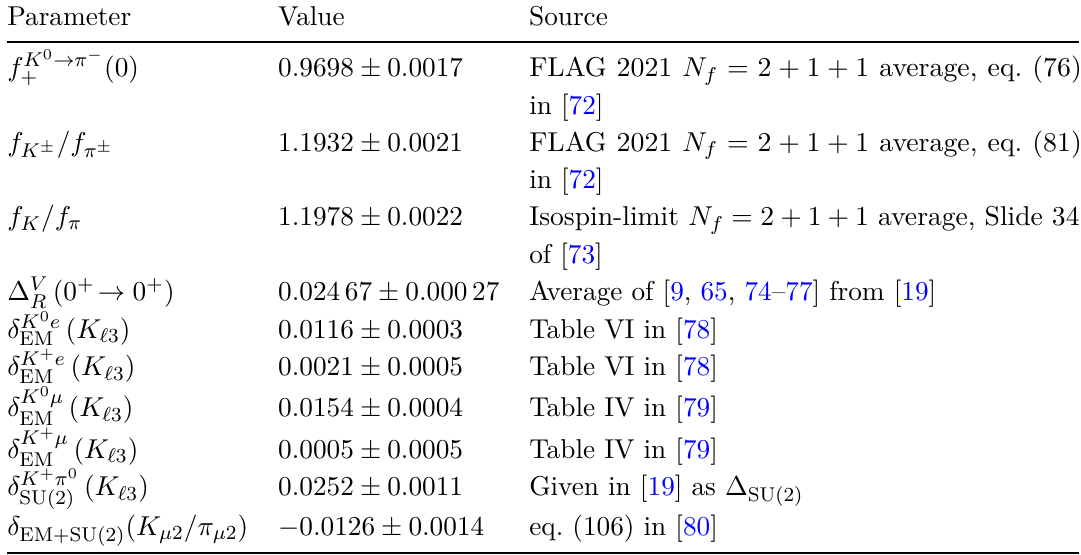
Table 2 . Updated values of the theoretical parameters which are used in this work. ∆ V universal nuclear-independent radiative correction to β decays (see main text for more details), δ EM are the electromagnetic corrections to K ‘ 3 decays (see references for details), δ isospin-breaking corrections to K ‘ 3 decays, and δ EM+SU(2) is the difference in combined lattice calculations for electromagnetic and strong isospin-breaking corrections to K µ 2 and π µ 2